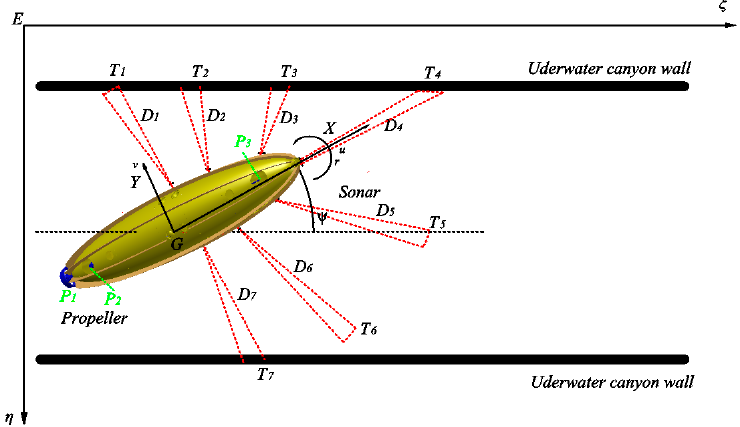
Figure 2. The geometric relationship of AUV facing continuous obstacles. Continuous surface of obstacles, the bold part of the Figure 2 represents the triangle symbol of the AUV position, T i ( i = 1, 2, 3, . . . 7 ) represents the underwater sonar of autonomous navigation and the continuous obstacle detection on the surface of the intersection, D i ( i = 1, 2, 3, . . . 7 ) is AUV to T i ( i = 1, 2, 3, . . . 7 ) point distance, ψ is the AUV yaw angle, point 7 sonar and AUV body the angle between the axis X , which can be deduced from the geometric relationship in Figure 2.